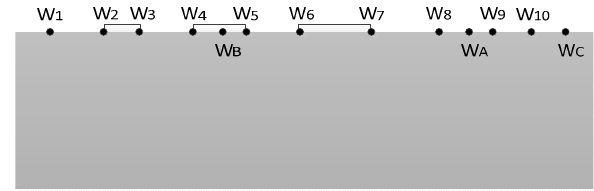
Figure 3. Transformation result in W plane.